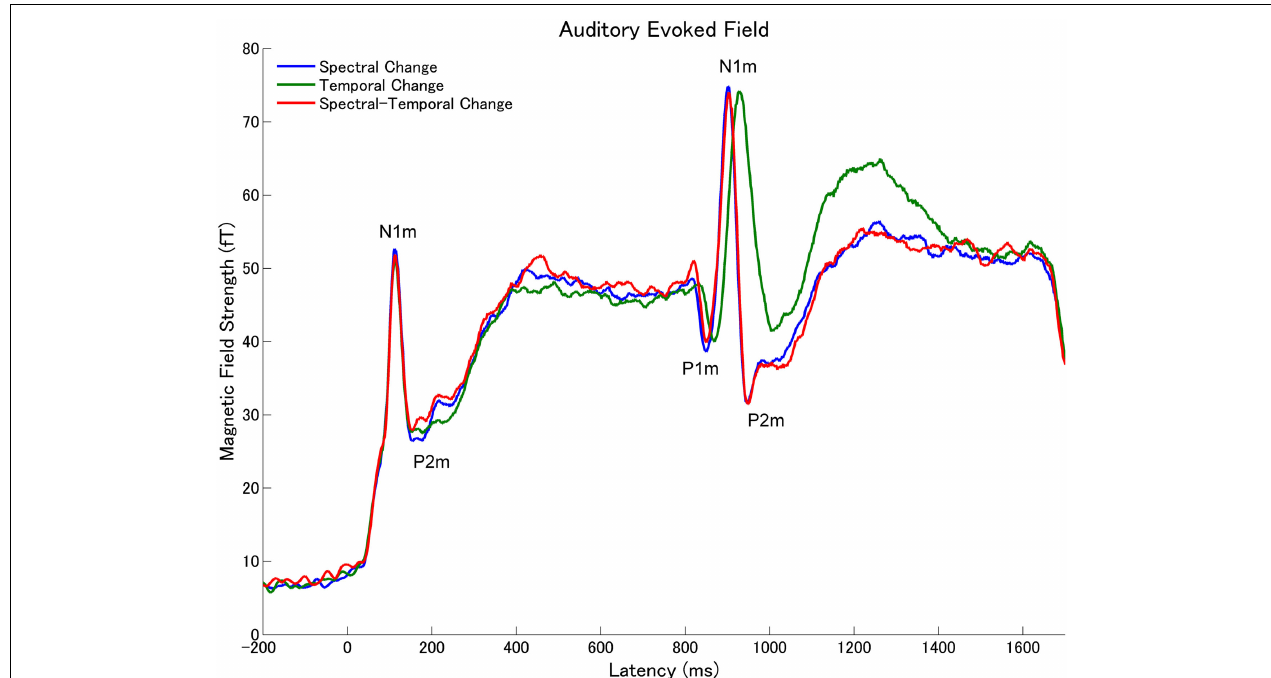
FIGURE 5 | Grand averaged root-mean-square (RMS) values of the magnetic fields of all sensors across all subjects ( N = 15) elicited by the tonal test stimuli (Figure 1) in experiment 1. The lines represent the spectral change (SC: blue line), temporal change (TC: green), or spectral–temporal change (STC: red) condition.